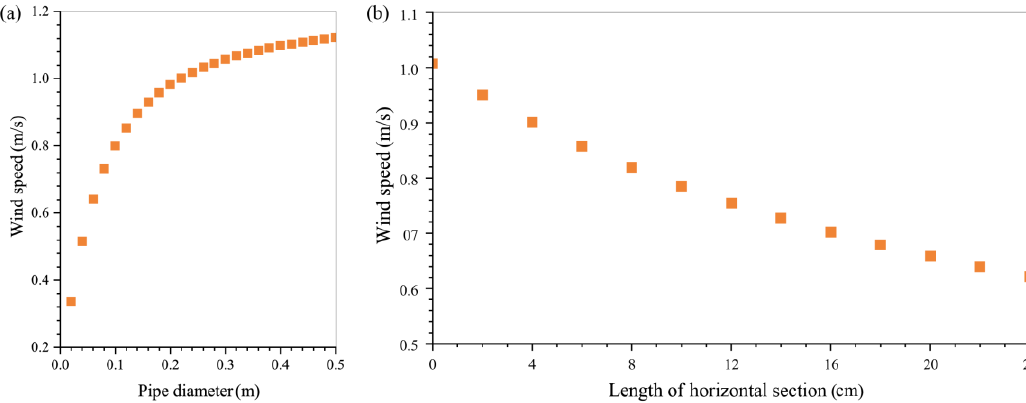
Fig 4 Figure 12. Analysis of the variation law of the maximum wind speed in the U-shaped air-ventilated pipe as a function of the ( a ) pipe diameter and ( b ) horizontal section